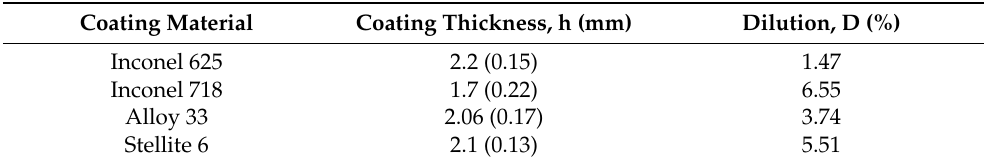
Table 3. Average of coating’s thickness value (with standard deviation) and dilution rate calculated on the base of macroscopic research.